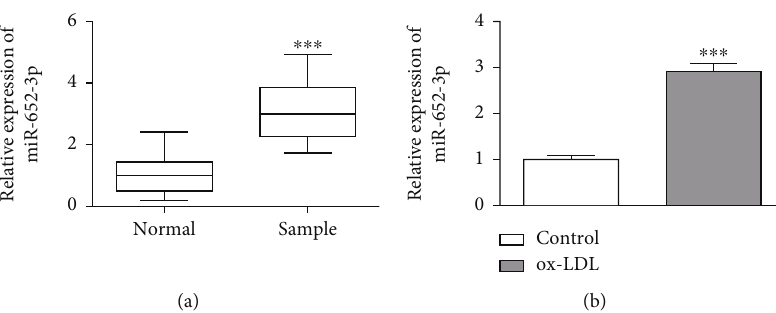
Figure 1: miR-652-3p expressed highly in atherosclerosis samples. (a) miR-652-3p was highly expressed in AS patients. (b) miR-652-3p was signi fi cantly higher in the ox-LDL group. ∗∗∗ P < 0 : 001 .